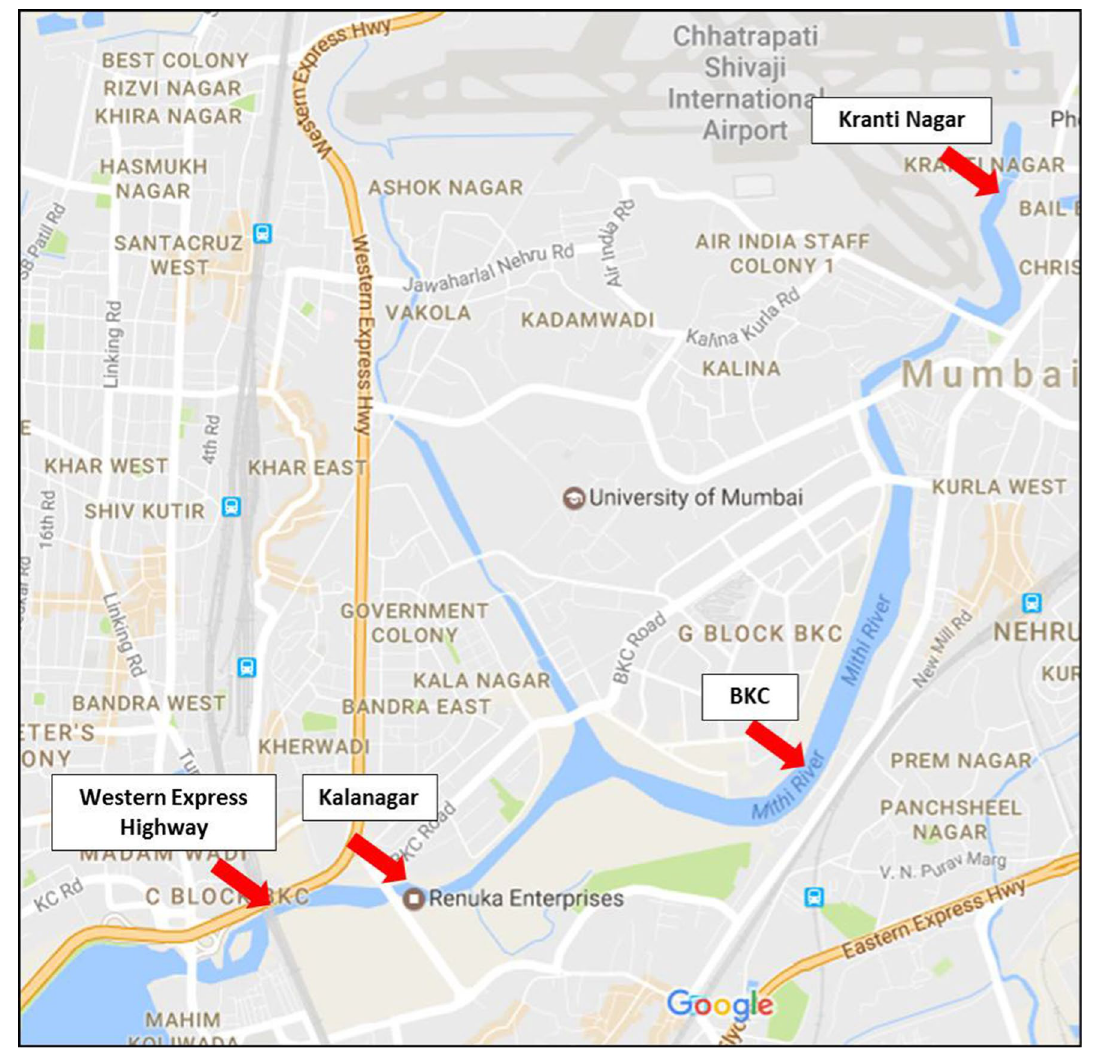
Fig. 1 Mithi river water sampling sites for isolation of mercury-resistant bacteria (Singare, 2015) Fig. 2 Agarose gel electropho- resis of 16S DNA amplified